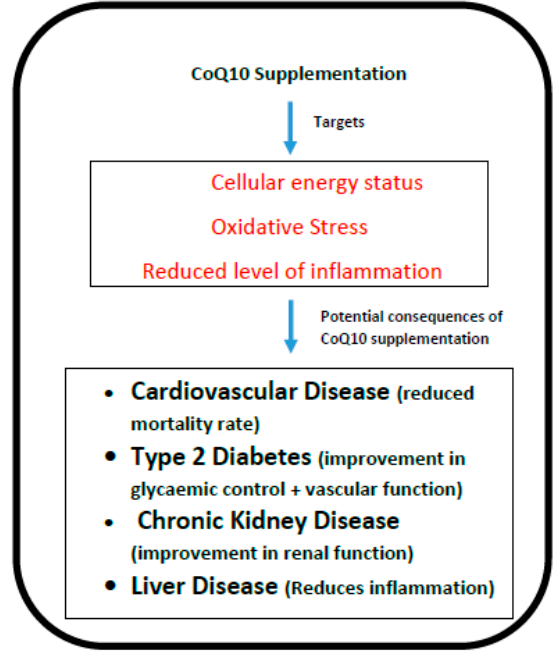
Figure 1. The potential targets and consequences of coenzyme Q10 (CoQ10) supplementation.